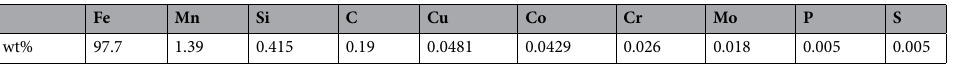
Table 1. Chemical composition of MS based on weight percentage.